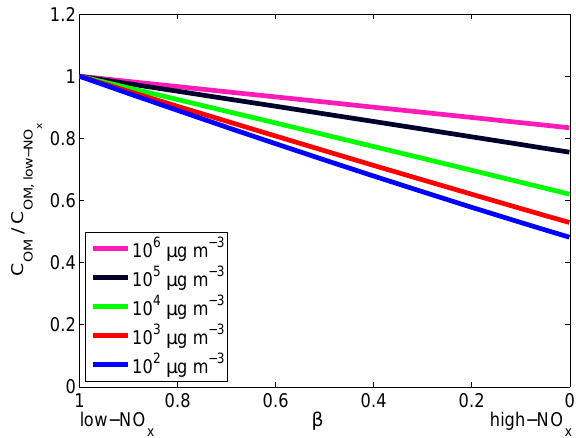
Figure 4. The effect of peroxy-radical branching on the first- generation secondary organic aerosol concentration, C OM . The x axis is the branching ratio for RO 2 reaction ( β ), where β = 1 corresponds to low-NO x conditions dominated by RO 2 + HO 2 and β = 0 corresponds to high-NO x conditions dominated by RO 2 + NO. The y axis is the ratio of C OM at a given value of β to the low-NO x value. Each curve represents a different amount of oxidized precursor, spanning 5 orders of magnitude from 10 2 to 10 6 µgm − 3 .